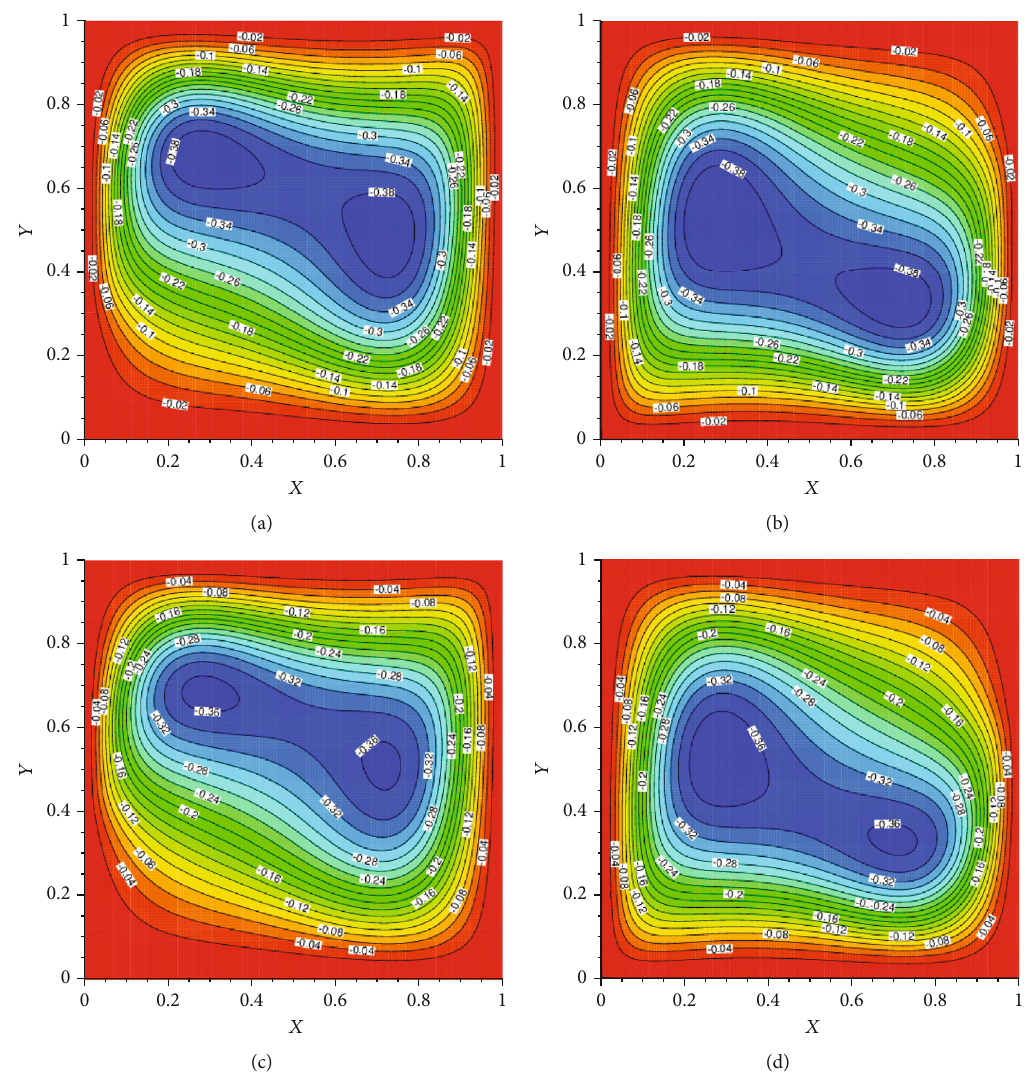
Figure 6: Stream function contours for h / H = 1/3 (a, b) and h / H = 1/5 (c, d), and Ra = 10 5 for hot (a, c) and cold (b, d)